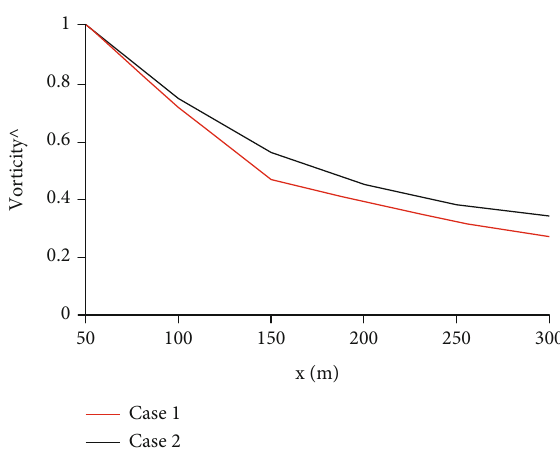
Figure 2: Vorticity curves at di ff erent positions when only the wing is retained and when the entire aircraft is